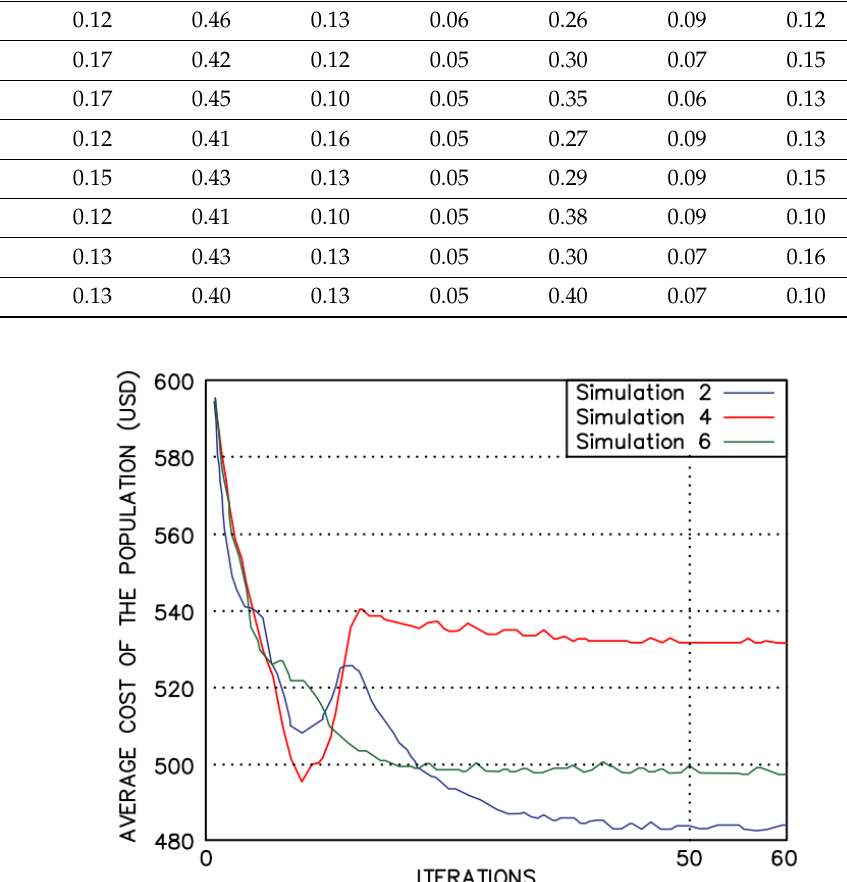
Table 2. Summary of solutions (150 individuals, 500 iterations, 5% mutation rate, and 𝜂 = 3 ).